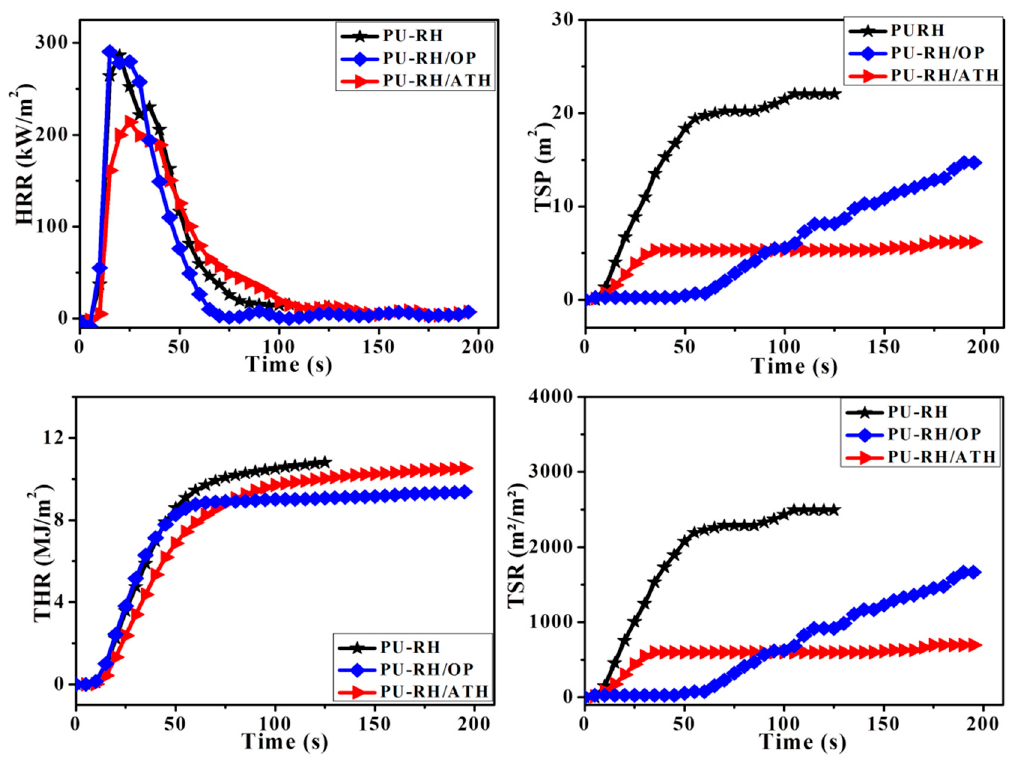
Figure 6. Cone calorimetry results for PU–RH, PU–RH/ATH, and PU–RH/OP.